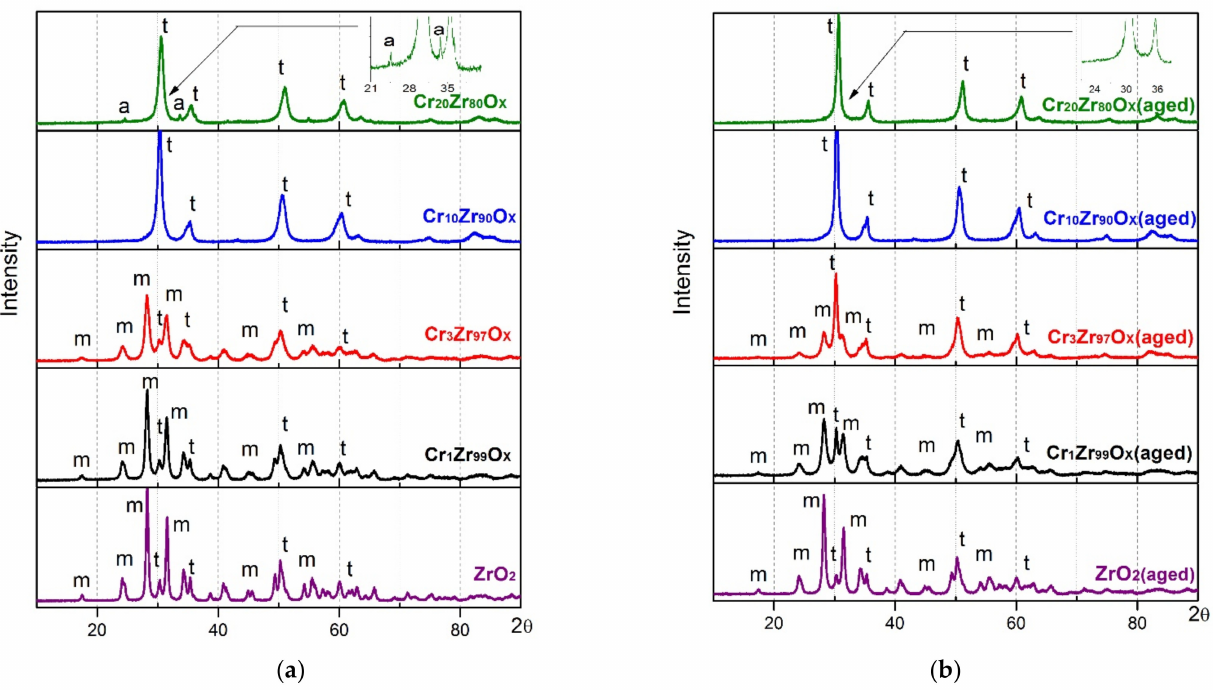
Figure 2. XRD patterns for Cr–Zr mixed oxide samples prepared ( a ) without and ( b ) with ageing of precipitate: m— monoclinic ZrO 2 phase, t—tetragonal ZrO 2 phase, a— α -Cr 2 O 3